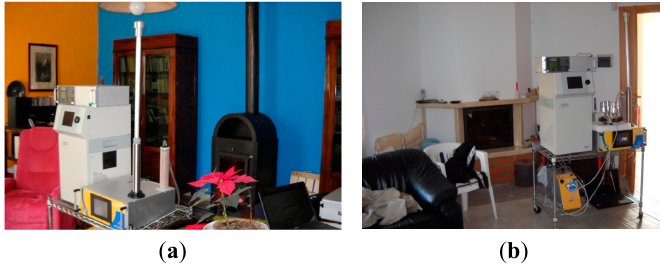
Figure 1. Instrument positioning in ( a ) House 1 and ( b ) House 5.